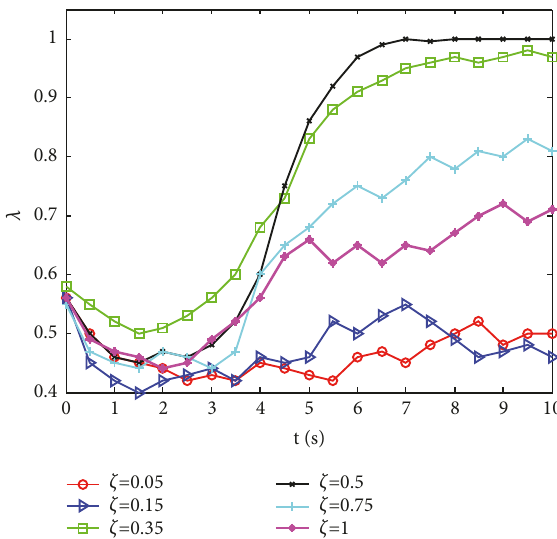
Figure10:Thedifferentiationindexofflockingsystemwithdifferent 𝜁 𝑖𝑗 .